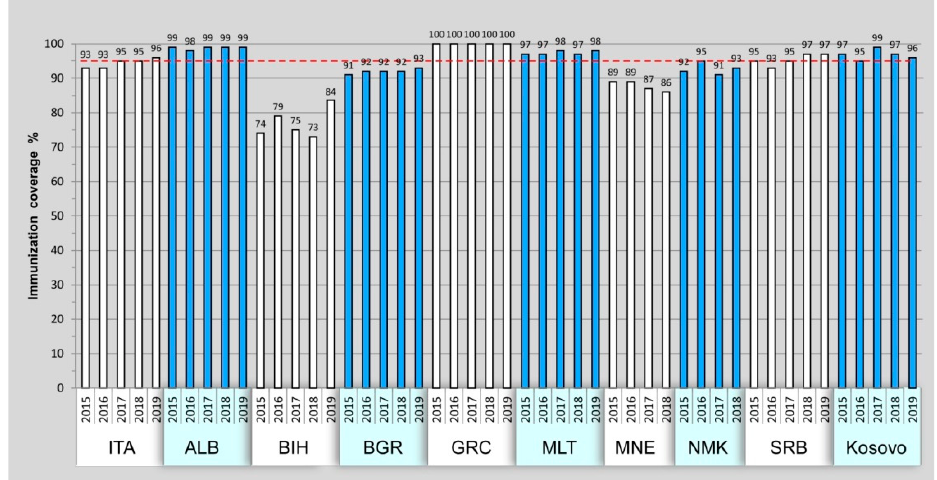
Figure 2. Three doses of polio vaccination coverage from 2015 to 2019 among children aged 12–23 months. Reference value of 95% coverage is shown by red line. Montenegro and North Macedonia lack data from 2019.